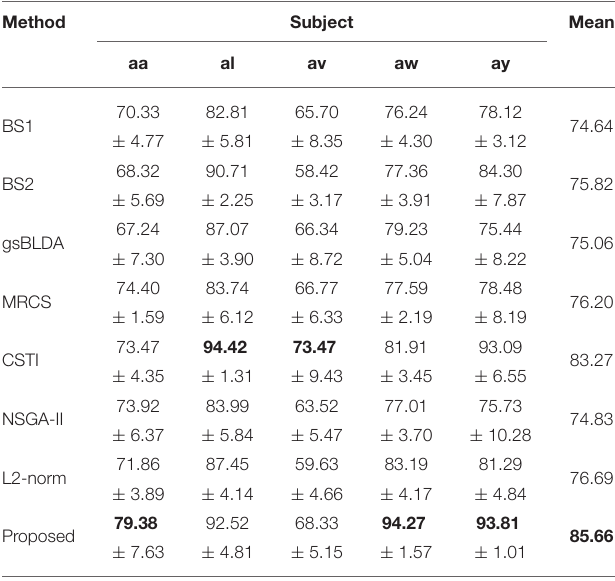
TABLE 4 | The mean F1 score and standard deviation (%) of 5 cross-validation of COL and baselines on 5 subjects of DS1. Method